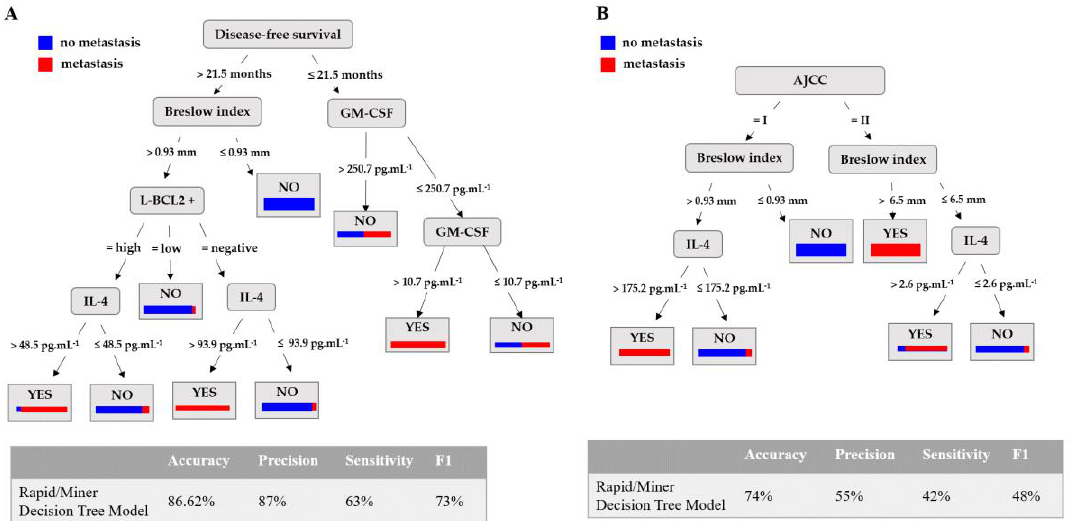
Figure 6. RapidMiner decision tree model to predict metastasis in early-stage melanoma patients (stages I and II). ( A ) The performance of the models obtained to predict the development of metastasis and the set of rules are shown in Figure S2C,D: disease-free survival is expressed in months; the Breslow Index in mm; L-BCL2 + represents the quantification of the intratumoral BCL2 + lymphocytes expressed as No (absence of BCL2 + intratumoral lymphocytes), Low (presence of small numbers of BCL2 + intratumoral lymphocytes), and High (presence of large numbers of BCL2 + intratumoral lymphocytes); and serum GM-CSF and IL-4 expressed in pg · mL − 1 . ( B ) The RapidMiner decision tree model trained with the original 149 patients but without the attribute disease-free survival (see rules in Figure S3B). The attributes used to predict metastasis are stage according AJCC Breslow index, and IL-4 and IL-6 serum